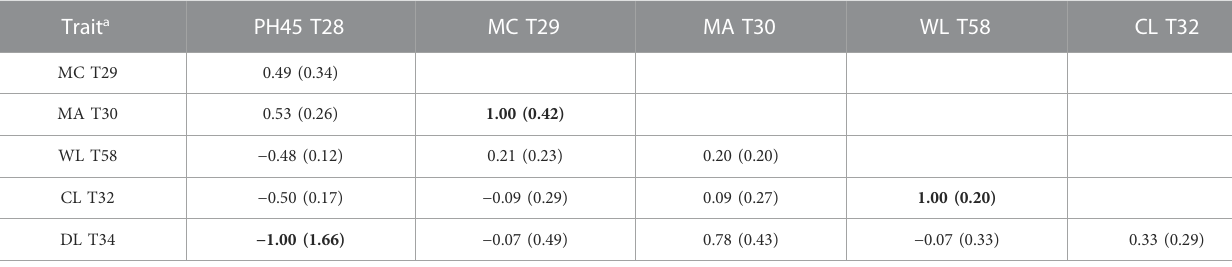
TABLE 3 Genetic correlations for six meat quality traits in crossbred pigs. Trait